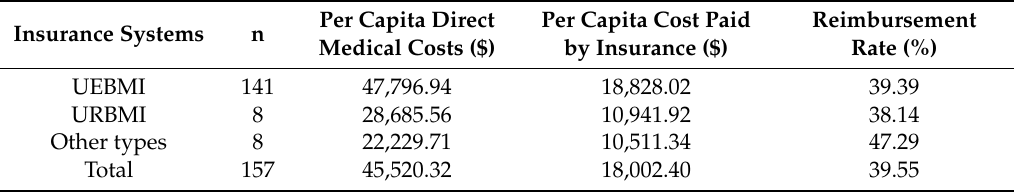
Table 4. Direct medical costs paid by type of medical insurance for insured